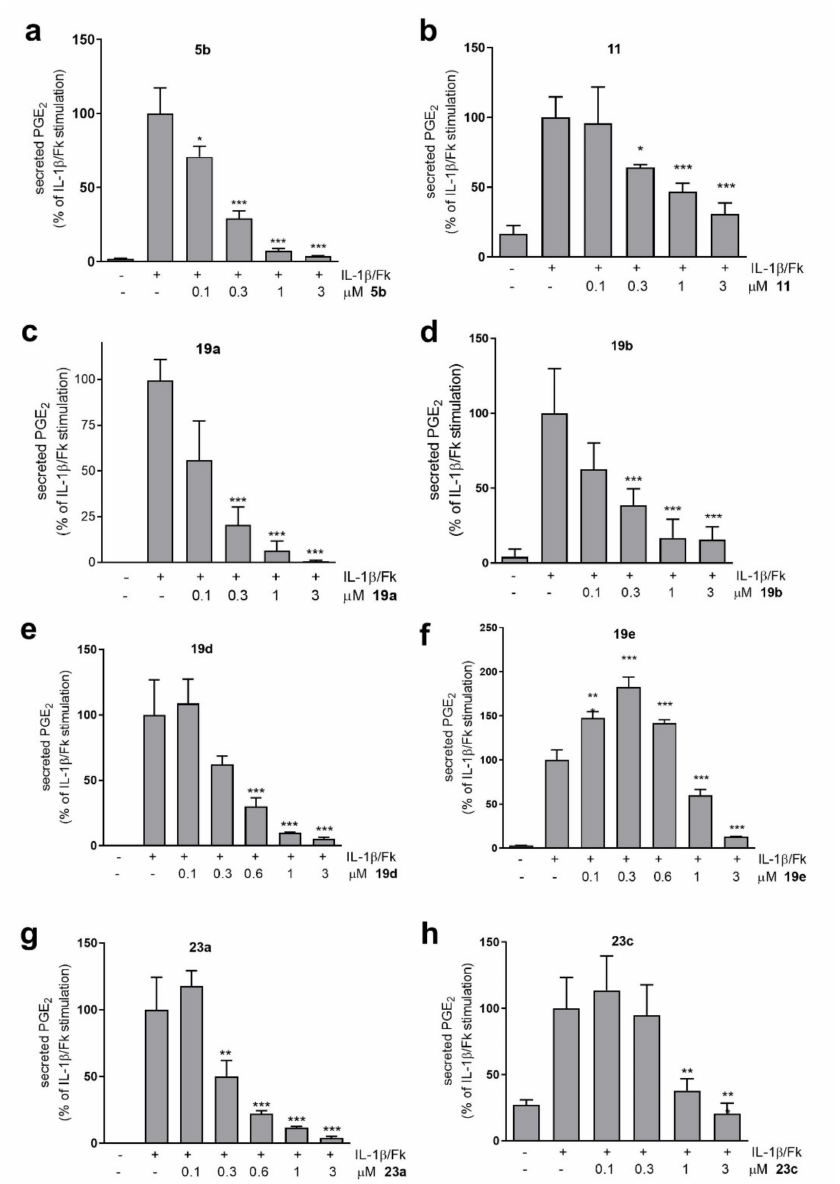
Figure 2. Effect of compounds 5b ( a ), 11 ( b ), 19a ( c ), 19b ( d ), 19d ( e ), 19e ( f ), 23a ( g ) and 23c ( h ) on IL-1/Fk-stimulated PGE 2 generation in rat mesangial cells. Cells were pretreated for 20 min with the indicated concentrations of inhibitors and then stimulated for 24 h in the absence ( − ) or presence (+) of 1 nM interleukin 1 β (IL-1) plus 5 µ M forskolin (Fk). PGE 2 was quantified in supernatants using an enzyme-linked immunoassay, as described in the Experimental section. Data are presented as % of IL-1/Fk stimulation and are means ± S.D.s (n = 3). * p < 0.05, ** p < 0.01, and *** p < 0.001 were considered statistically significant when comparing with the IL-1/Fk-stimulated